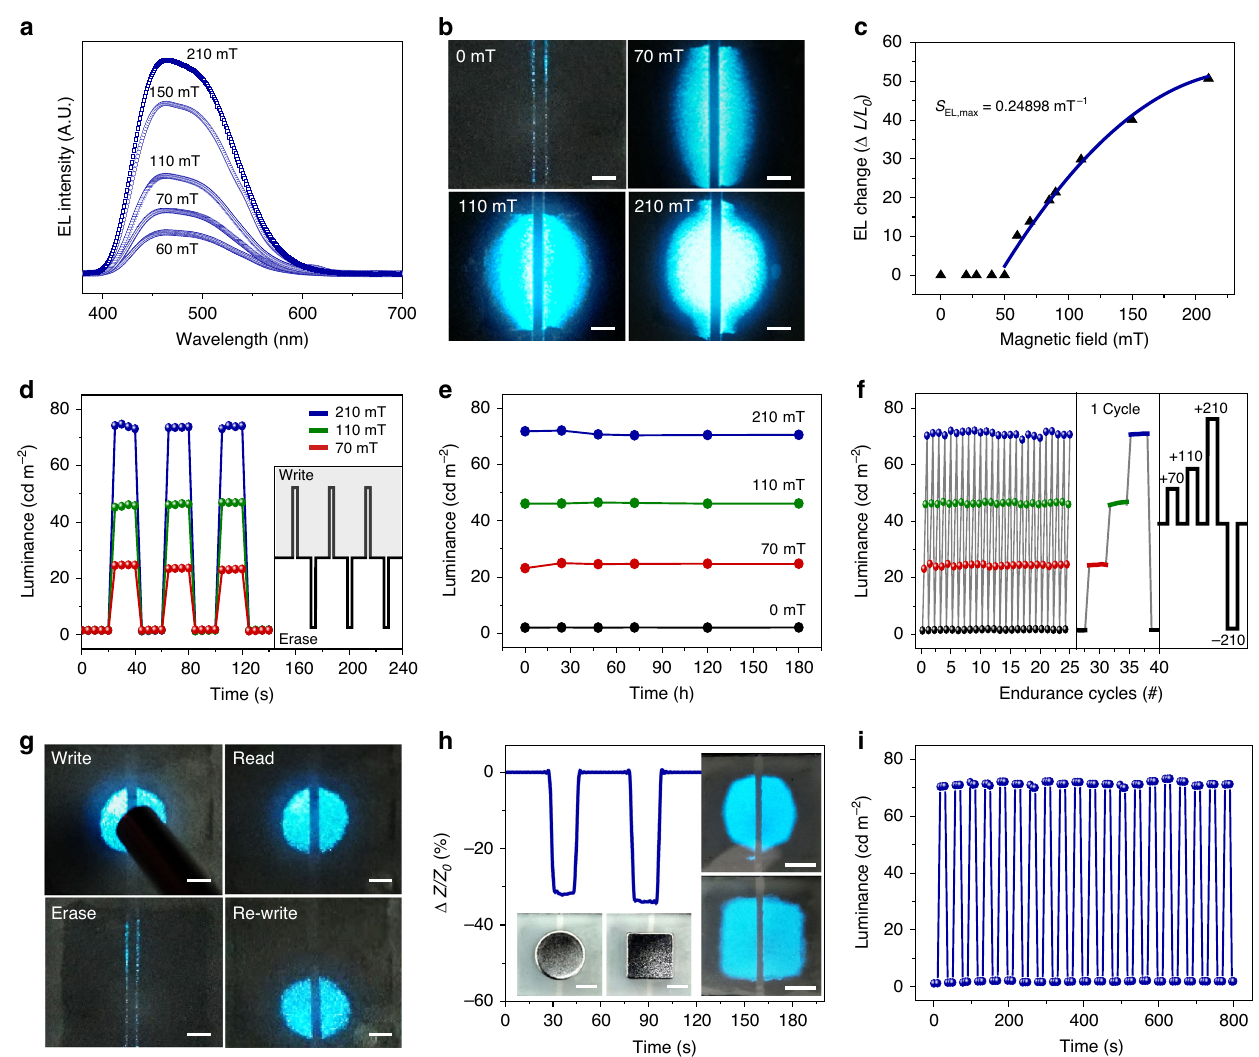
Fig. 2 Properties of an NV-MED sensing, visualising, and memorising a magnetic fi eld. a EL intensity of NV-MED under different applied magnetic fi elds from 60 to 210 mT. b NV-MED under different magnetic fi elds, i.e. 210, 110 and 70 mT (scale bars: 1 mm). c Plots of the change in EL intensity of an NV- MED as a function of magnetic fi eld. d Variation in EL intensity of an NV-MED in writing and erasing with different magnetic fi elds. A scheme of magnetic fi eld programming for writing and erasing the EL in inset. e Time-dependent retention of EL intensity arising from an NV-MED with different magnetic fi elds. f Write – erase endurance cycle of EL intensity changes of an NV-MED. The inset shows the EL intensity change in one cycle and scheme of four magnetic fi eld programmes for the endurance cycle. g NV-MED demonstrating the EL-based magnetic fi eld programme/erase process (scale bars: 4 mm). h NV-MED with different magnetic- fi eld shapes showing the direct visualisation of the magnetic fi eld in EL with the device (scale bars: 5 mm). i Endurance cycle test of EL intensity under 210 mT magnetic fi